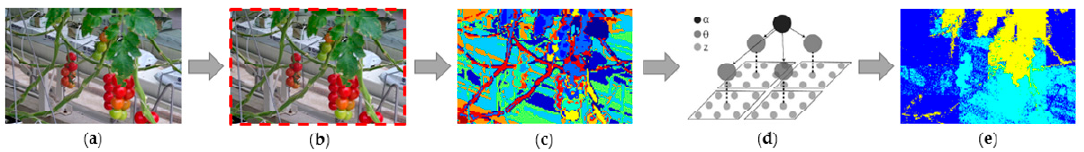
Figure 4. Process of word document encoding based on fixed non-overlapping grid. ( a ) Original image; ( b ) Consider the whole image as one document; ( c ) Quantified visual words; ( d ) Word document model: α is the prior parameter for the document topic distribution; θ is the multinomial parameter for the topic distribution; z is the corresponding topic for the denoted word; ( e ) Segmentation result.